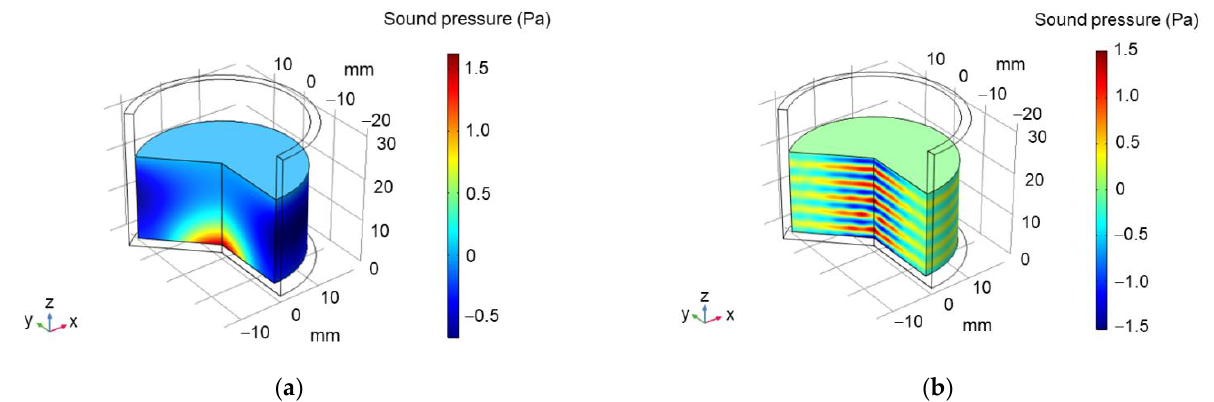
Figure 4. Simulated distribution of sound pressure at the driving frequency of 28 ( a ) and 400 kHz ( b ). The flask is 20 mm in diameter, 32 mm in height, with the wall thickness of 2 mm. The numerical simulations were performed using the COMSOL software.